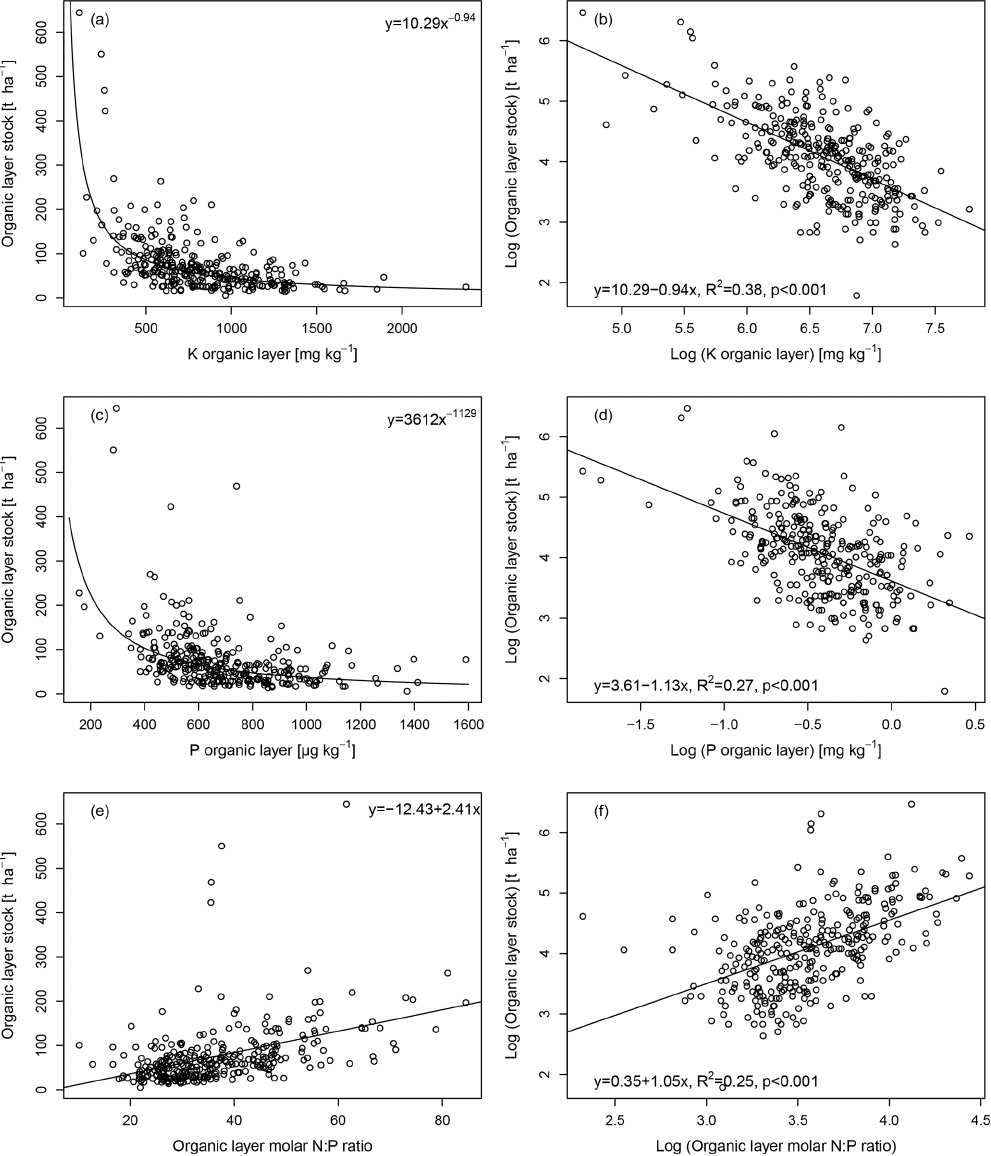
Figure 5. The organic layer stock as a function of the organic layer K concentration shown for the original data with a power function (a) and the log-transformed data with a linear model (b) , as well as the organic layer stock as a function of the organic layer P concentration shown for the original data with a power function (c) , the log-transformed data with a linear model (d) , and the organic layer stock as a function of the organic layer molar N : P ratio shown for the original data (e) and the log-transformed data with a linear model (f)